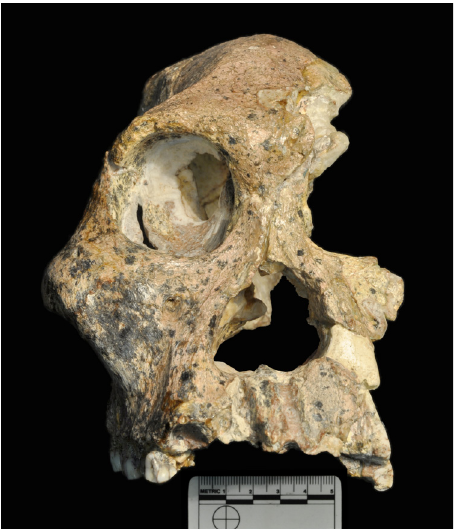
Fig. 2: Australopithecus